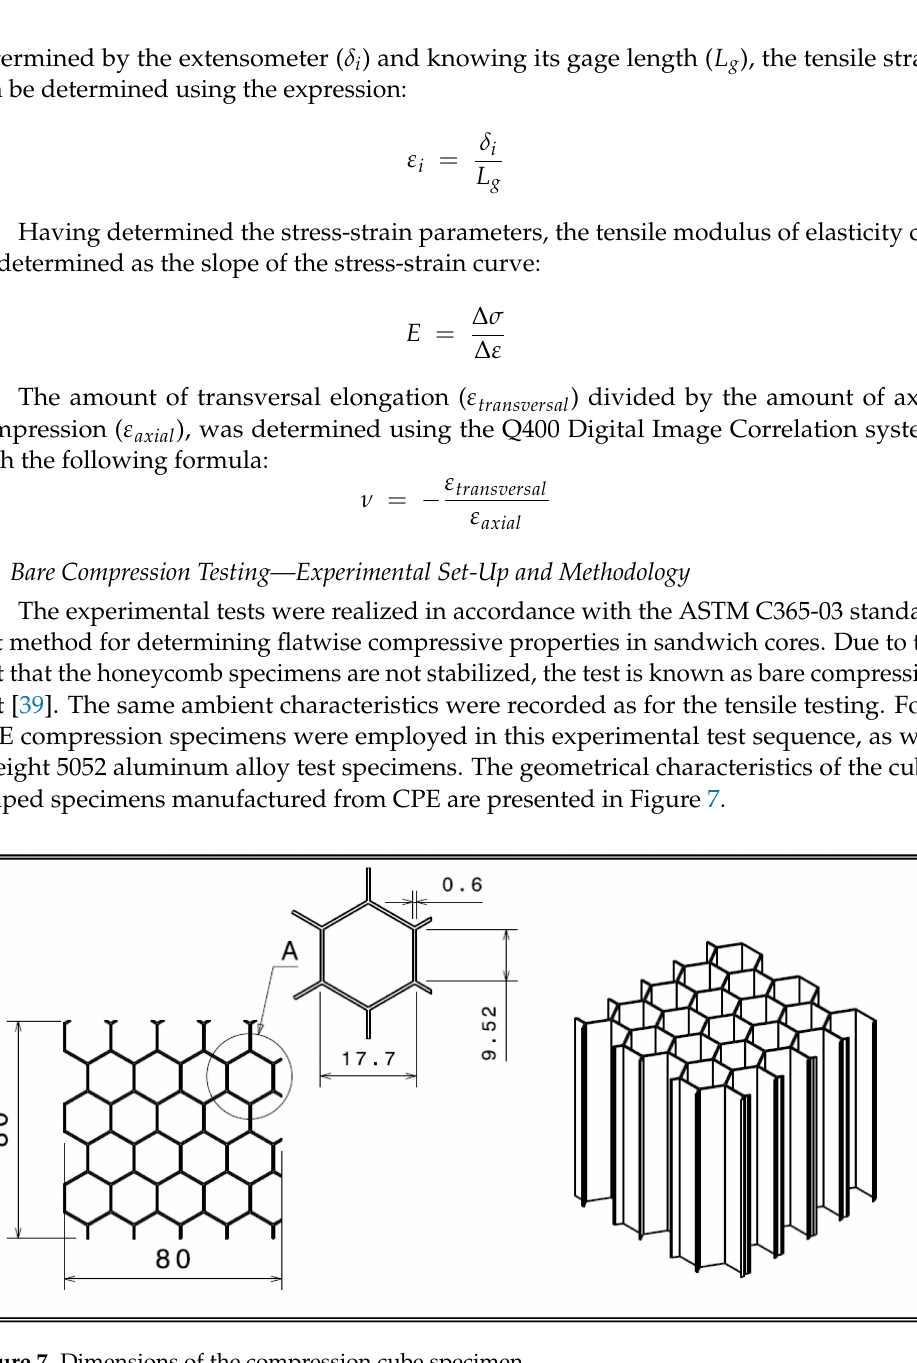
Figure 7. Dimensions of the compression cube